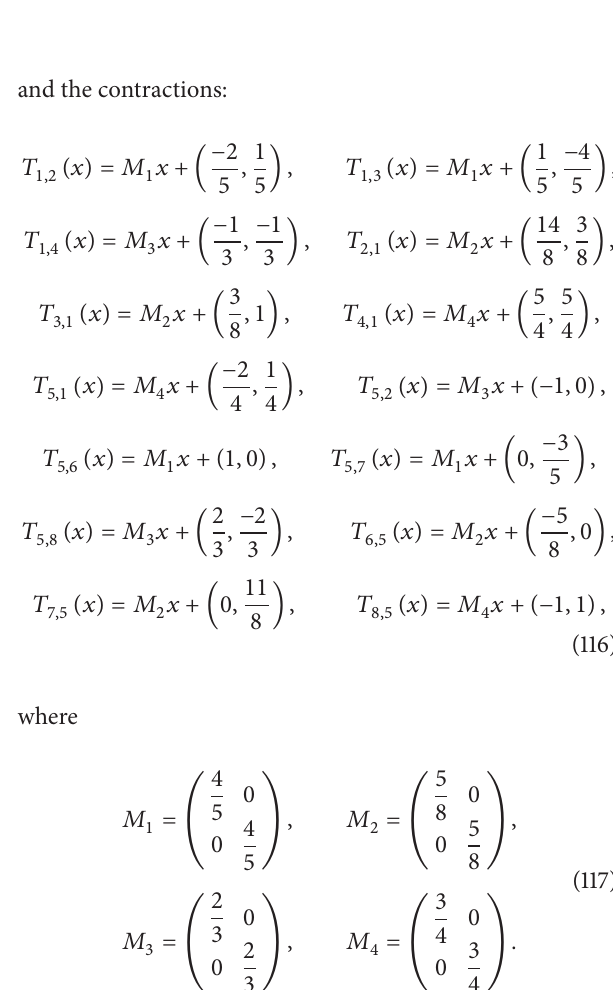
Figure 4: The set 𝐾 + (𝐶 2 )